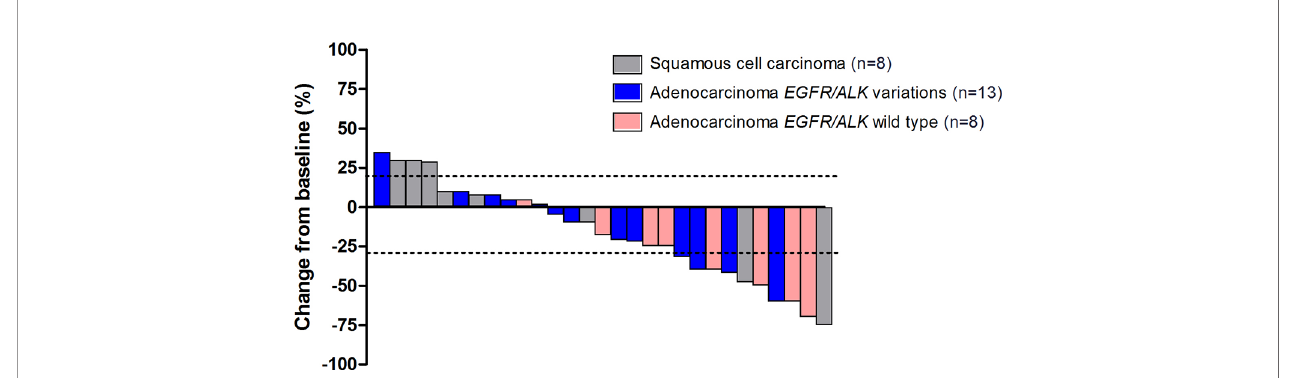
FIGURE 4 | The maximum percentage reduction from baseline in sum of target lesions based on histology and EGFR/ALK status (n = 29).